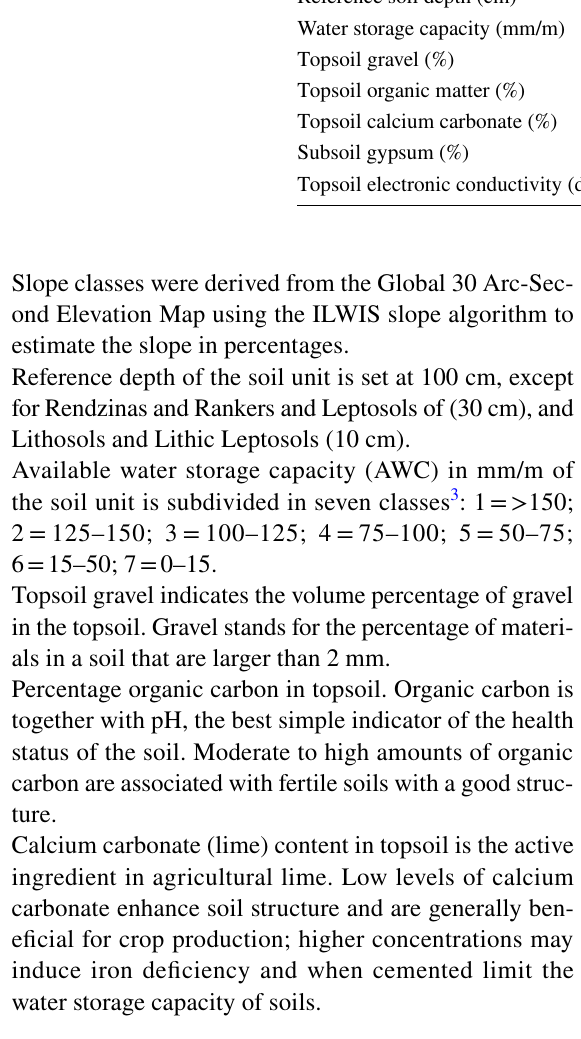
Table 2 Soil attributes and land suitability classes for date palm